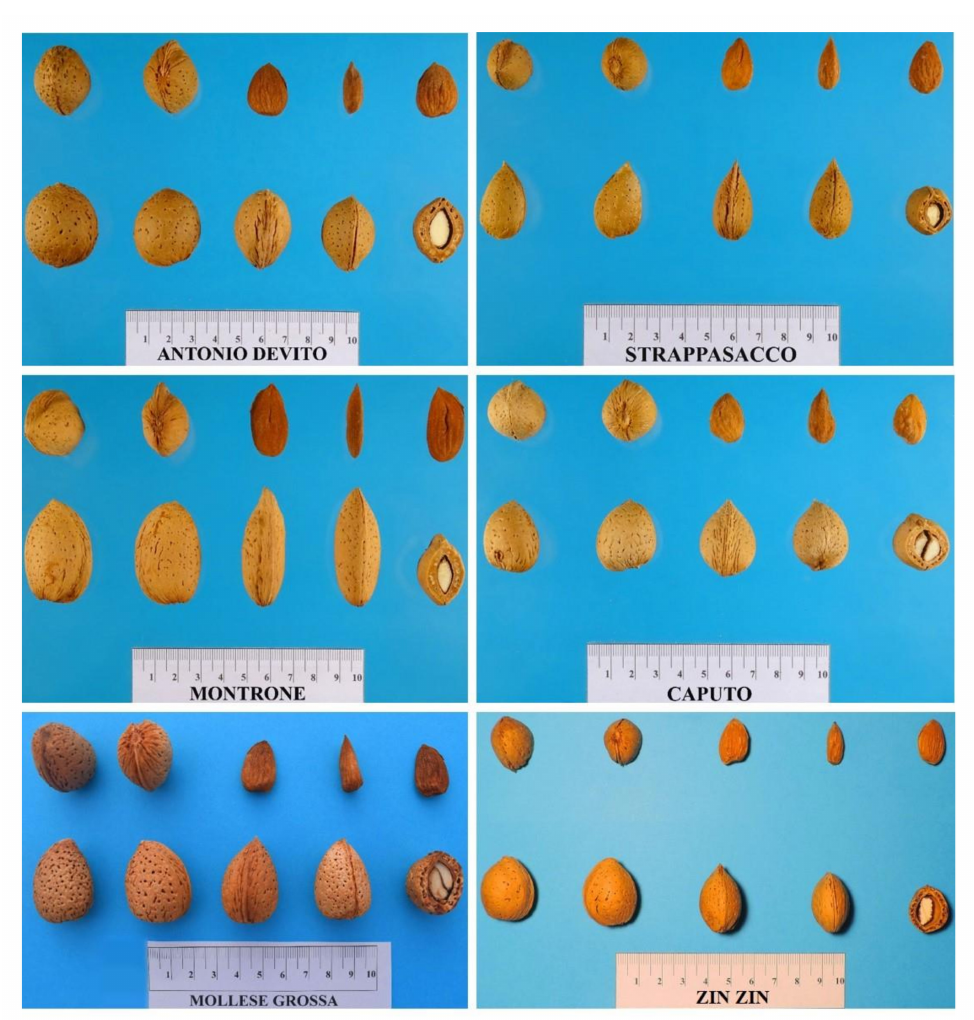
Figure 5. Nut and kernel morphology of some Apulian almond